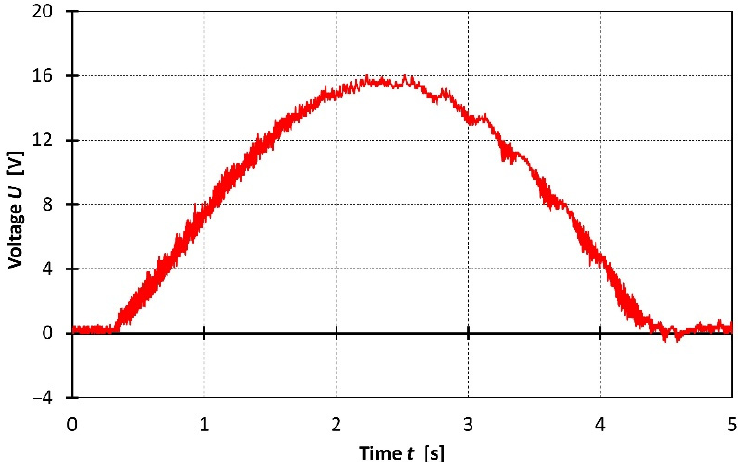
Figure 24. Time profile of the angular position at the joint.